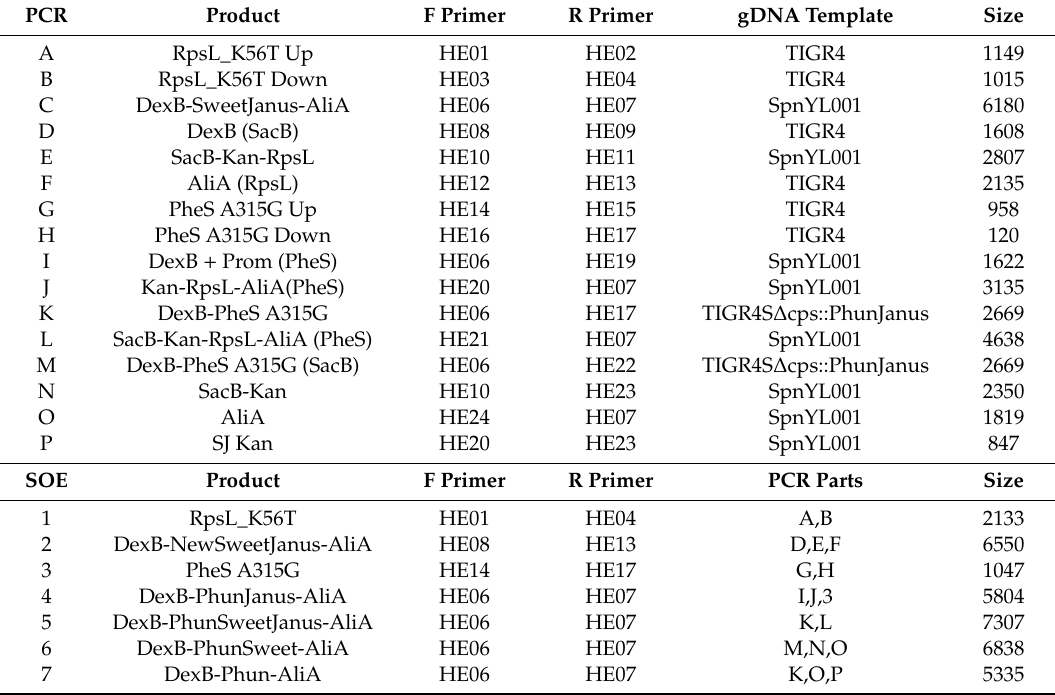
Table 4. PCR (polymerase chain reaction) setup for cassette. Words in parentheses indicate overhang homology.